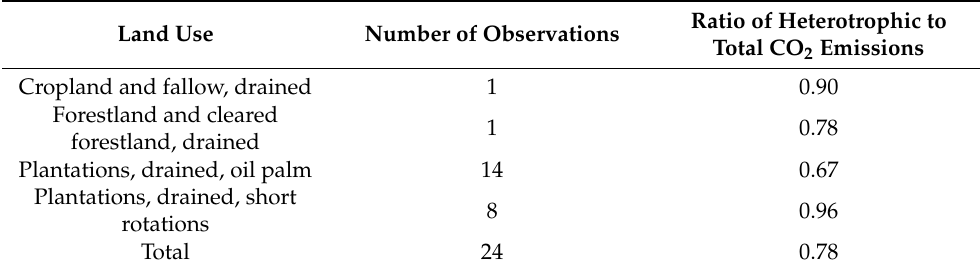
Table 2. Ratio of heterotrophic to total CO 2 emissions from the primary studies in peatlands. Ratio of Heterotrophic to Land Use Number of Observations Total CO 2 Emissions Cropland and fallow, drained 1 0.90 Forestland and cleared 1 0.78 forestland, drained Plantations, drained, oil palm 14 0.67 Plantations, drained, short 8 0.96 rotations Total 24